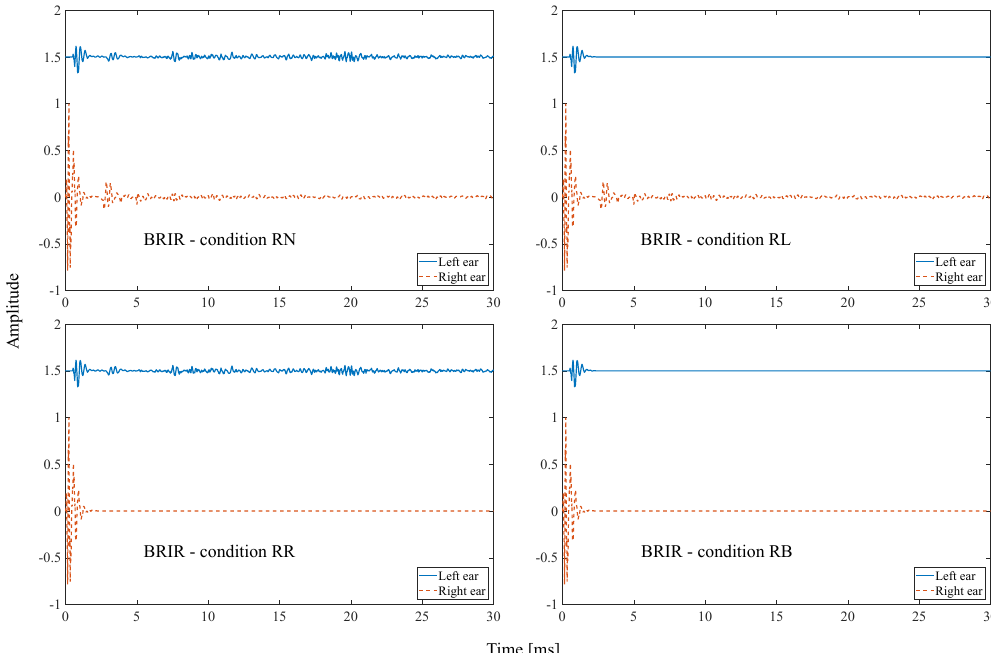
Figure 5. Examples of BRIRs with modified reverberant parts at 60° for the “RN” (left top), “RL” (right top), “RR” (left bottom), and “RB”(right bottom) conditions in the time domain. The solid and dashed curves denote the modified BRIRs of left and right ears, respectively (the left ear BRIR was offset by 1.5 for better visibility).